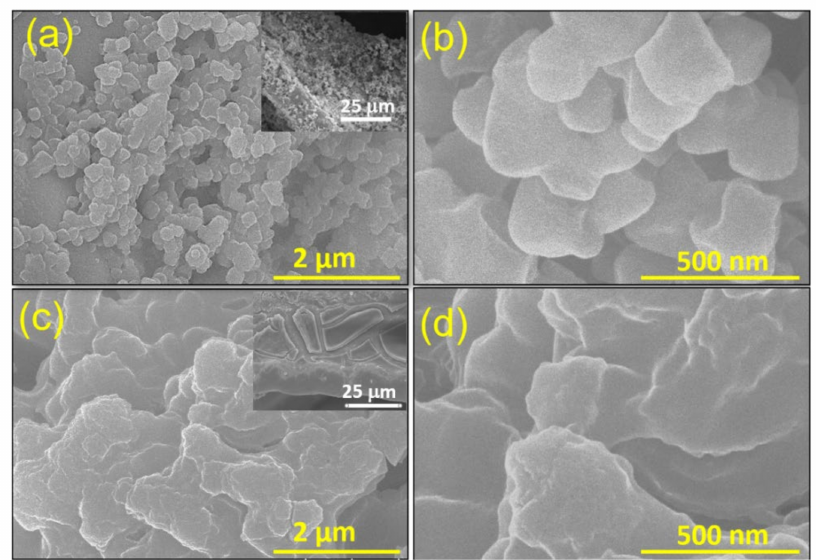
Figure 1. SEM images of the drop-casted ( a , b ) Fe-MOF and ( c , d ) Cu/Fe-MOF films on a nickel foam at various magnifications. Inset images are the lower magnified SEM views of the corresponding samples in microscale range.